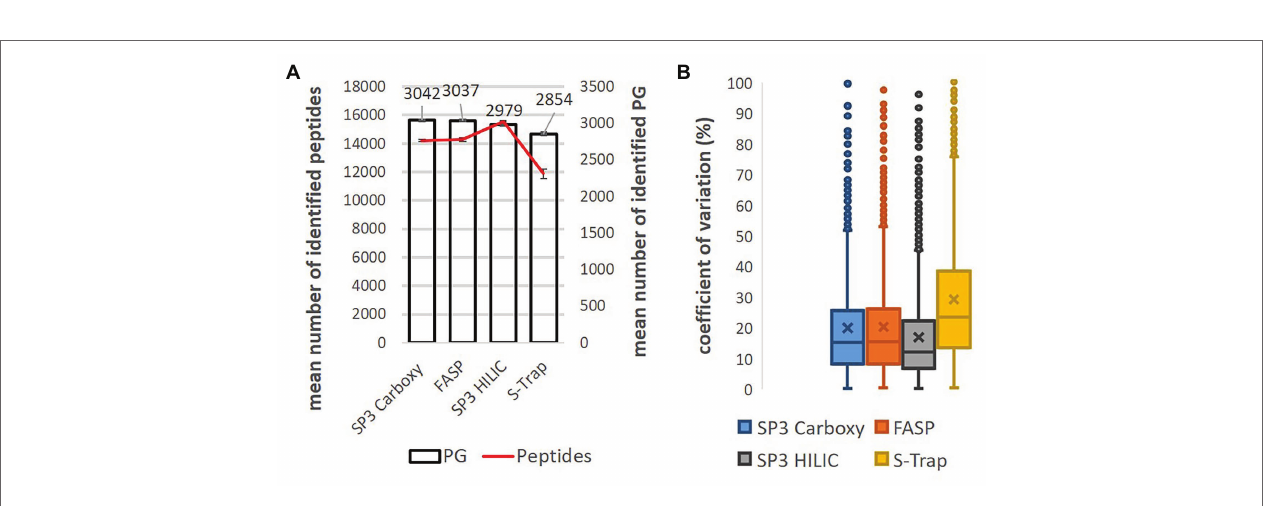
FIGURE 2 | Comparison of SP3 Carboxy, FASP, SP3 HILIC, and S-Trap performance (18 h digestion, trypsin:protein 1:10, three replicates). (A) Mean number of identified protein groups (bar chart) and peptides (line chart). Technical variability of protein group and peptide detection is displayed as error bars. (B) Coefficients of variation of protein group intensity (%). Only shared protein groups ( n = 1986) across the whole dataset were considered. Median normalization was applied [data were log (2)